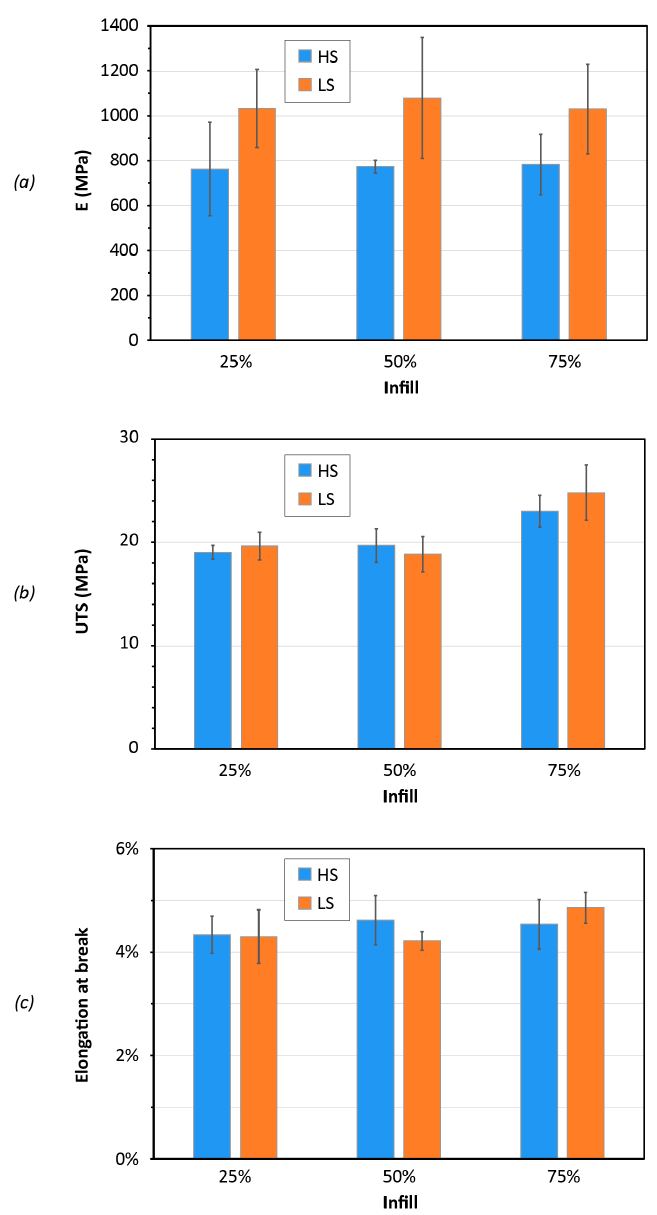
Figure 8. Mechanical performance of the dumbbell specimens for three different infill percentages (25%, 50%, 75%) and the two printing-speed sets of high speed (HS) and low speed (LS): elastic modulus ( a ); ultimate tensile strength ( b ) and elongation at break ( c ).